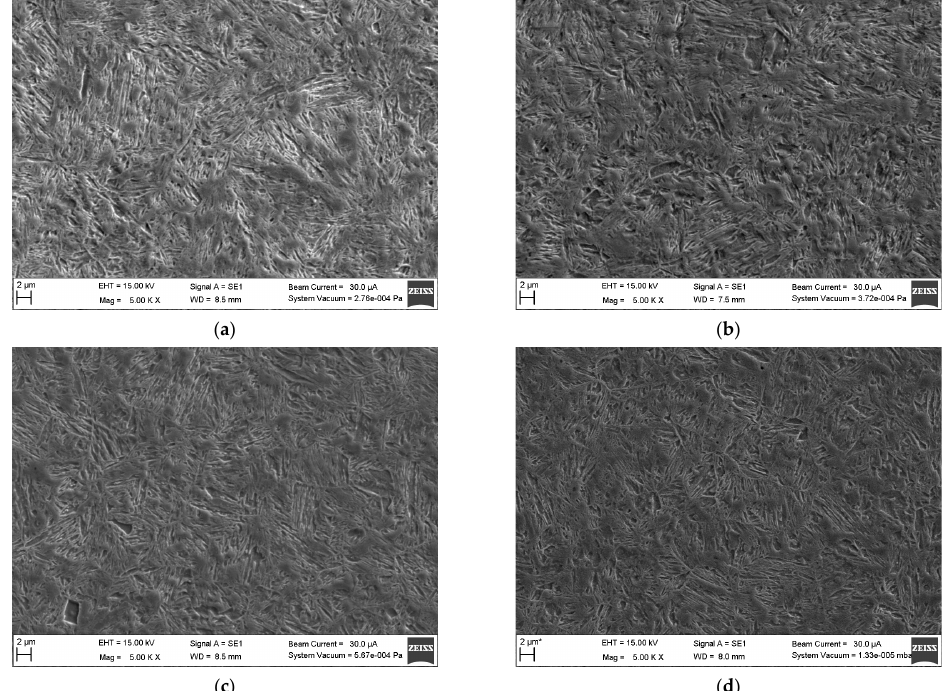
Figure 5. Microstructures from scanning electron microscope imaging of the standard Q-P with ( a ) half cooling rate, ( b ) quarter cooling rate, ( c ) double cooling, and ( d ) 3.12% cooling from 292 °C to 200